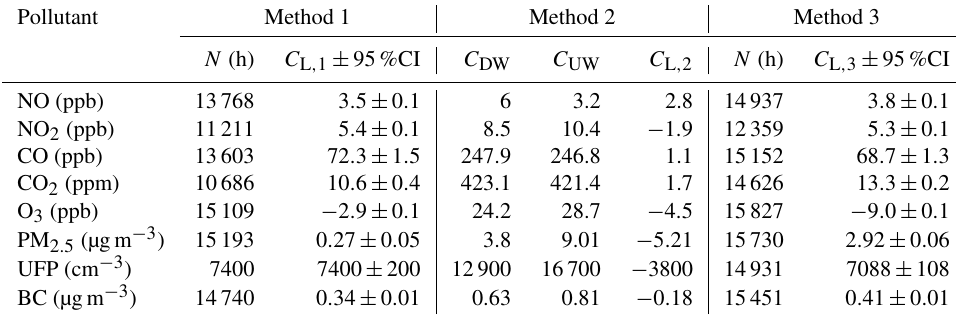
Table 3. Mean local pollutant concentrations at NR-TOR-2 determined using each background-subtraction